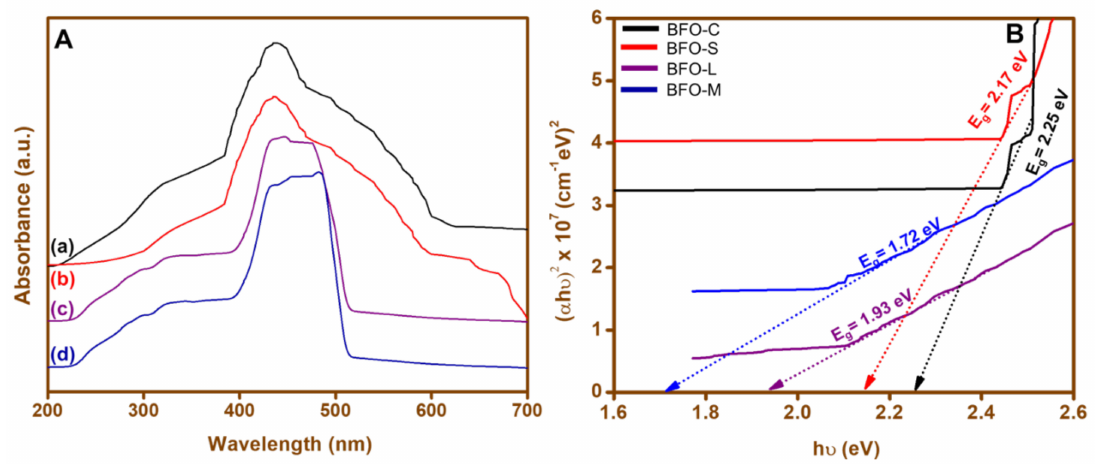
Figure 2. ( A ) UV–vis spectra and ( B ) band gap graph for (a) BFO-C, (b) BFO-S, (c) BFO-L, and (d) BFO-M